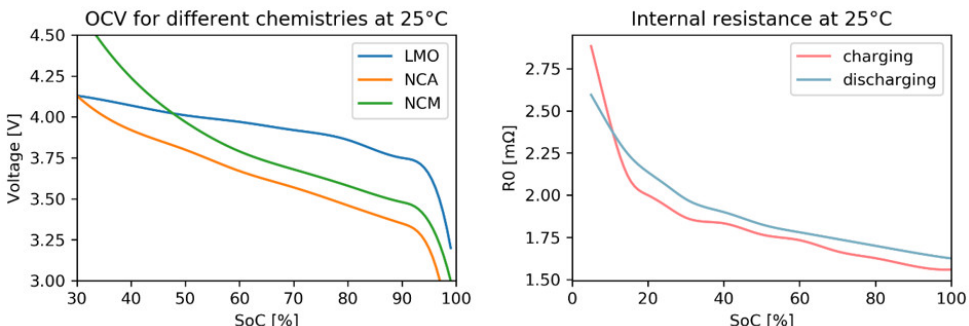
Figure 5. SoC–OCV curves for different battery chemistries ( left ) [28] and battery cell internal resistance as a function of SoC and operation ( right ) [22]. Left figure based on Bharathraj et al. [28] and authors’ further elaboration.